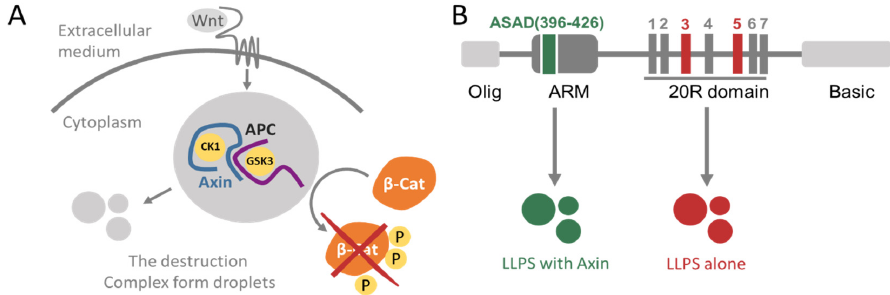
Figure 1. Schemes of Wnt signaling and the domain structure of APC ( A ) a scheme of Wnt signaling. When active, the destruction complex, composed of the sca ff old proteins APC and Axin along with